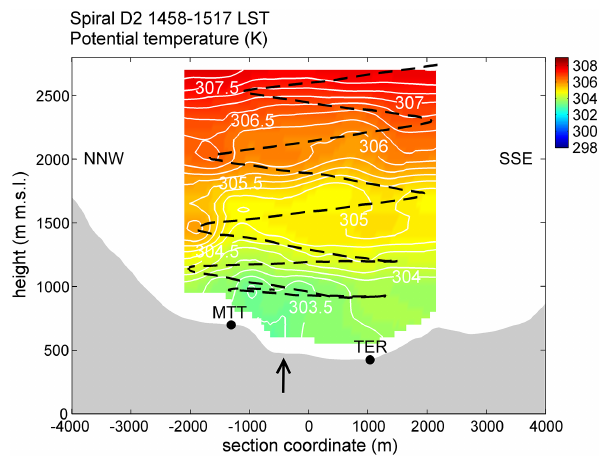
Figure 12. As in Fig. 7 but for spiral E2. The horizontal coordi- nate marks the local cross-valley direction for the Adige Valley. The black arrow on the left represents the Ora del Garda overflowing from the Lakes Valley through the Terlago saddle into the Adige Valley. The projection of the position of RON1, RON2 and GAR is also indicated (black